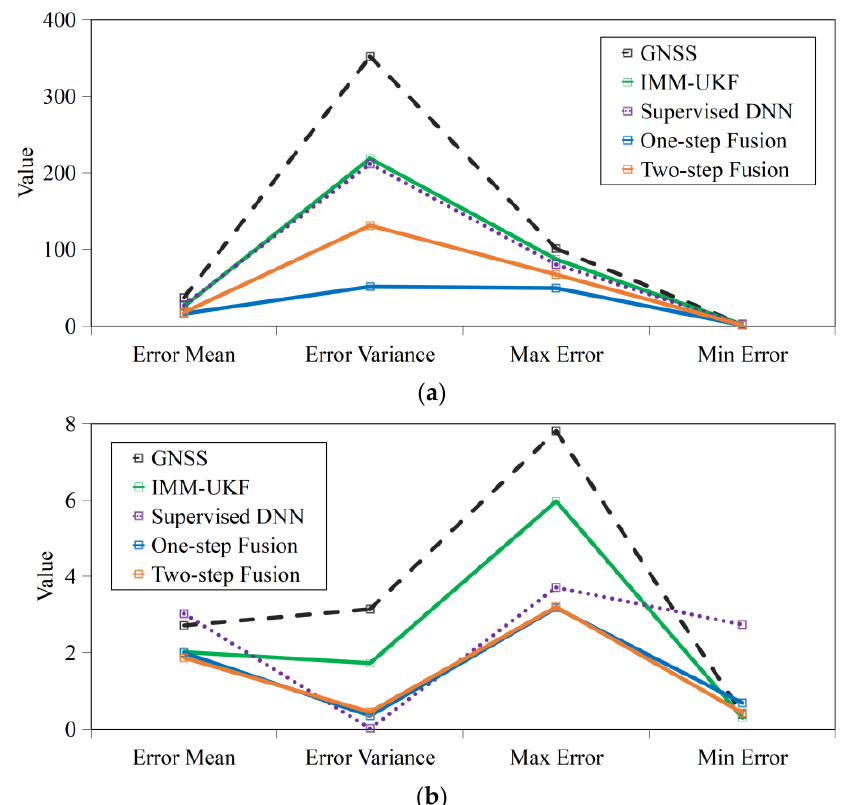
Figure 7. Statistical parameters of location errors. ( a ). Statistical parameters of location errors in Scenario 1. ( b ). Statistical parameters of location errors in Scenario 2.